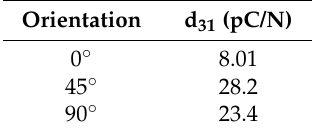
Table 1. Piezoelectric charge constants of electro‐active paper (EAPap) according to material orientation [31].